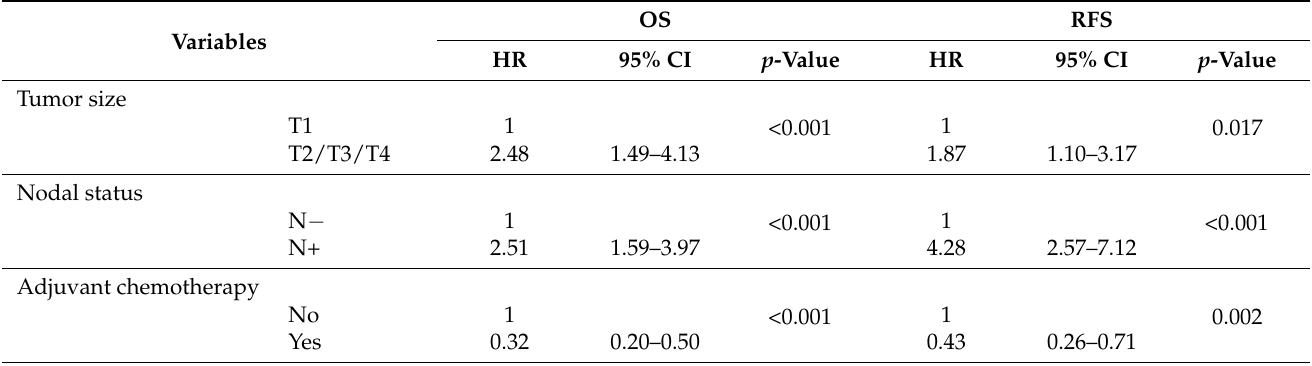
Table 5. Multivariate analysis of survivals.